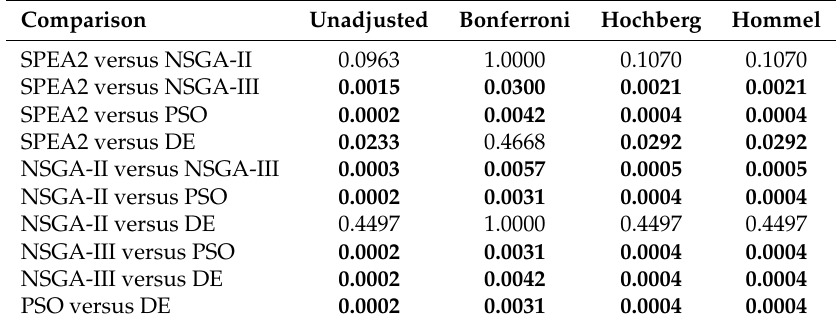
Table 3. Adjusted p -values for multiple comparisons between all metaheuristics. Significant values are those p -values shown in